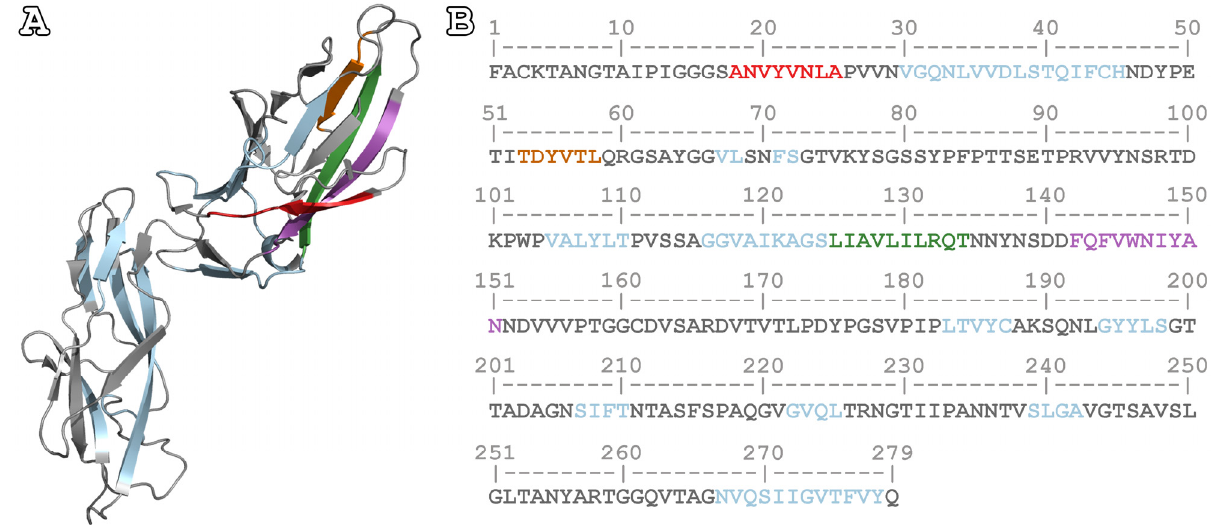
Figure 1. Native structure and mature sequence of FimH. ( A ) The native structure of FimH, in the absence of any ligand (PDB ID: 3JWN) [17]. The selected peptide-analogues for the experimental study are located in the lectin domain, close to the loops forming part of the mannose-binding site. ( B ) The amino acid sequence of FimH. The predicted APRs have been highlighted with light blue, while the experimentally studied APRs have been marked in different colors. More specifically, the segments colored in red, orange, green and purple depict the APRs 18 ANVYVNLA 25 , 53 TDYVTL 58 , 125 LIAVLILRQT 134 , and 142 FQFVWNIYAN 151 , respectively. Segments with low aggregation propen- sity are shown in grey.